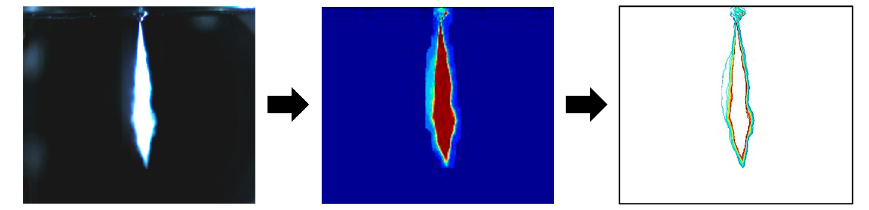
Figure 3. Experimental extraction of impingement velocity.